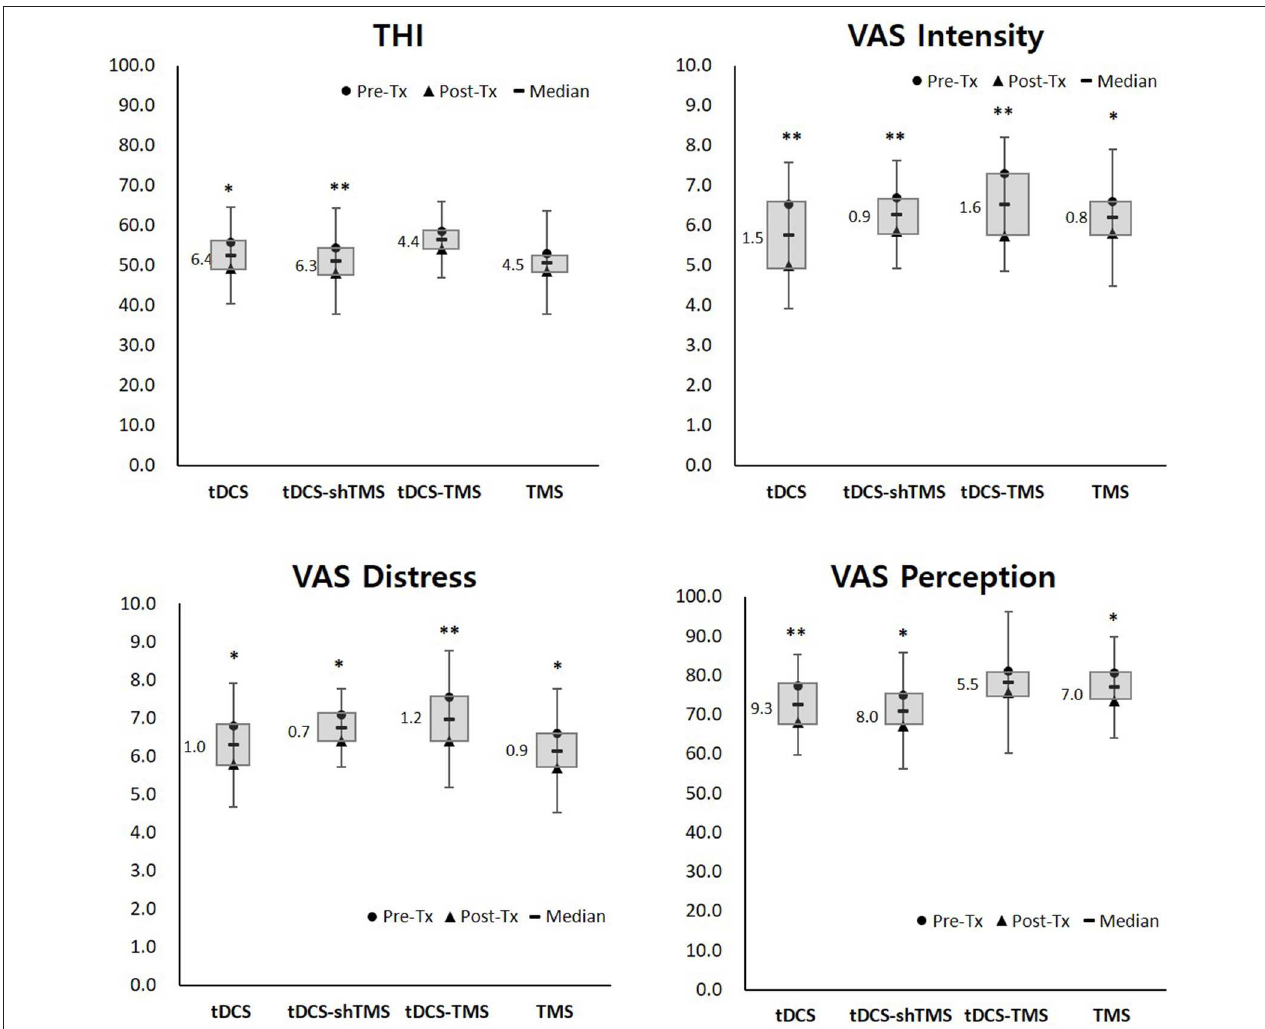
FIGURE 2 | Pre- and post-treatment questionnaire scores of the four study groups. Single asterisk (*) designates P < 0.05 while double asterisks (**) designate P < 0.01. THI, tinnitus handicap inventory; VAS, visual analog scale; Tx, treatment; tDCS, transcranial direct current stimulation; TMS, transcranial magnetic stimulation; sh,